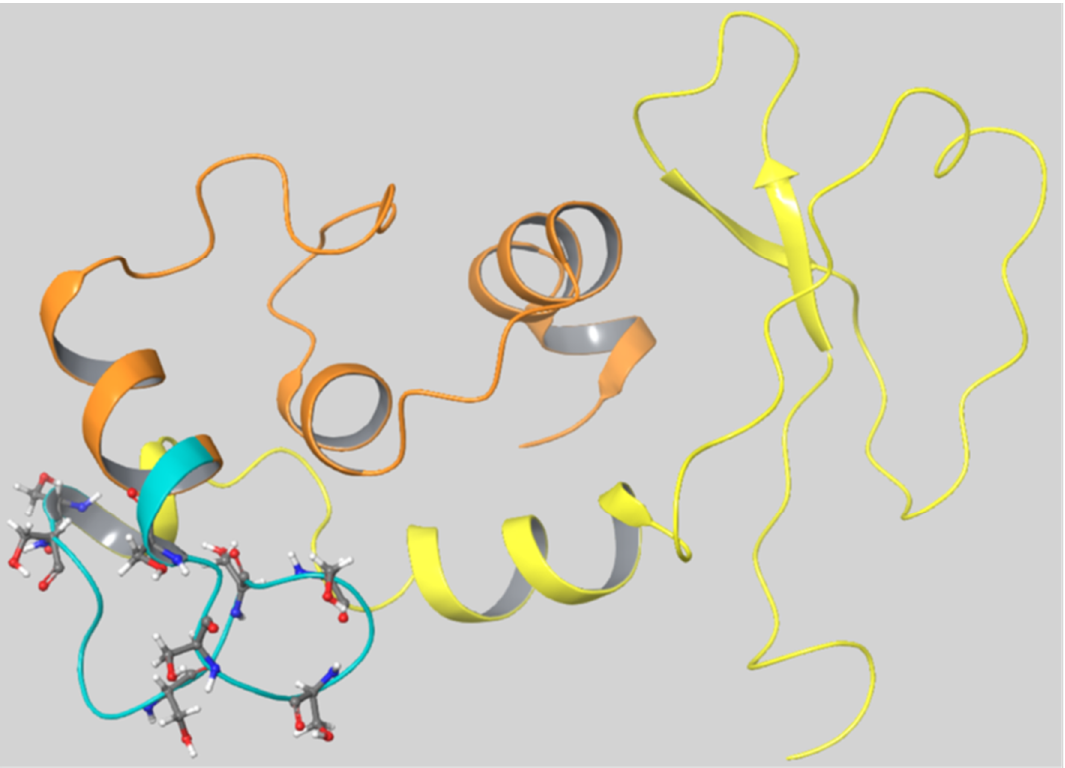
Figure 8. Predicted structure of the SG core protein. The prediction was based on the primary structure of the SG core protein using the Phyre 2 program as described in the Materials and Methods. The N-terminal amino acids from 1–66 are labeled yellow; the amino acid stretch from 67–83, which contains the Ser-Gly repeats that bind the CS chains, are labeled in light blue; and the C-terminal stretch from amino acids 84 to 131 are labeled in orange. Shown are the eight serine residues that are the putative CS chain attachment sites with nitrogen in blue, carbon in grey, oxygen in red, and hydrogen in white. The SG docking with FnII resulted in 130 poses, while the docking with HPX gave 77 poses. The best poses were selected using four steps (Scheme 1).